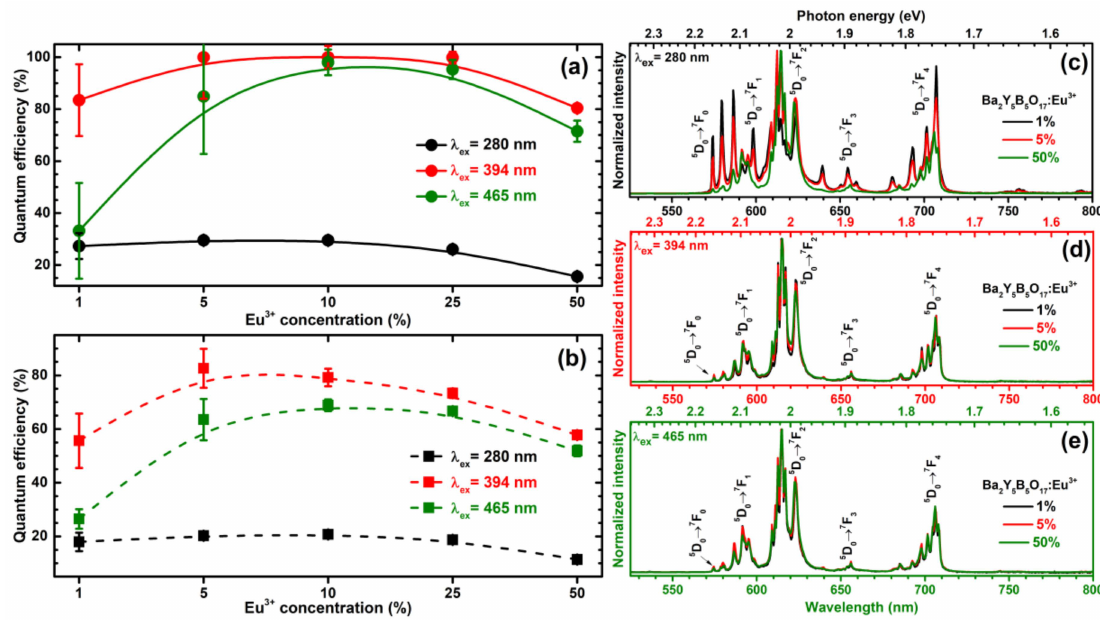
Figure 6. Quantum e ffi ciencies of Ba 2 Y 5 B 5 O 17 :Eu 3 + samples as a function of Eu 3 + concentration and excitation wavelength for 500–800 nm range ( a ) and 500–650 nm range ( b ). Emission spectra of 1%, 5% and 50% Eu 3 + -doped specimens under 280 nm ( c ), 394 nm ( d ), and 465 nm ( e ) excitation